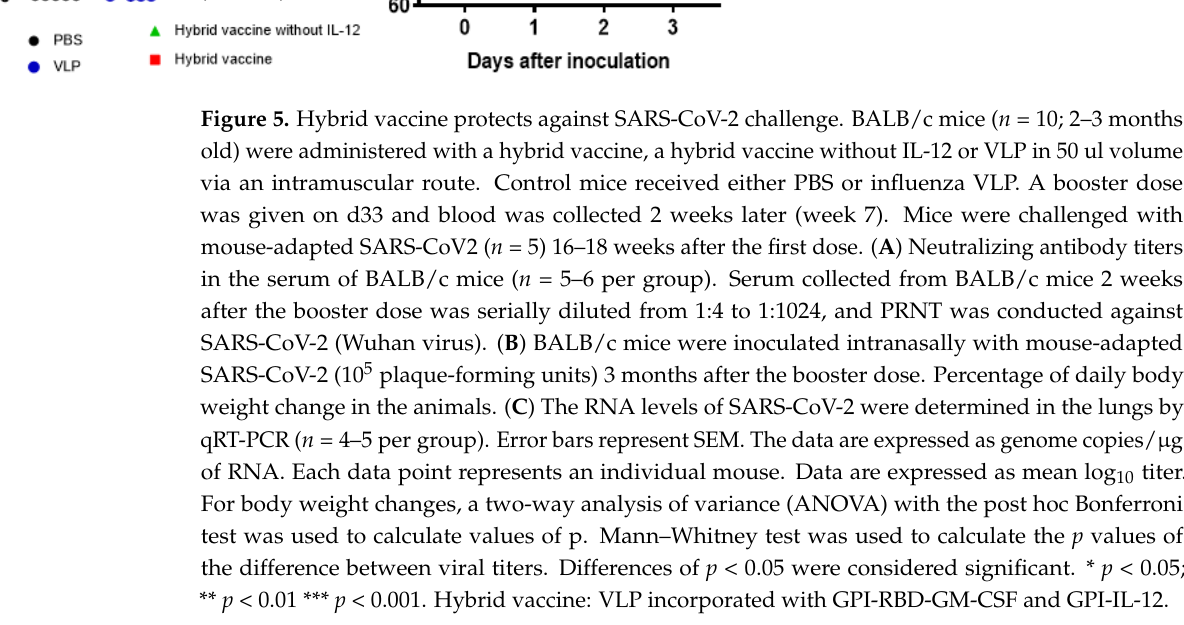
Figure 4. Hybrid vaccine induces influenza A/PR8 virus-specific antibody response. ( A – C ) ELISA plates were coated with inactivated influenza A/PR8 H1N1. Serum samples from mice vaccinated with VLP, VLP with GPI-GM-CSF and GPI-IL-12 or hybrid vaccine were serially diluted (5-fold) and added to the wells after blocking the plates. ( D ) Hemagglutination inhibition (HAI) titer in the sera of mice. Isotype specific anti-mouse Ig-HRP conjugate was used to detect the isotype of the antibody bound. * p < 0.05.